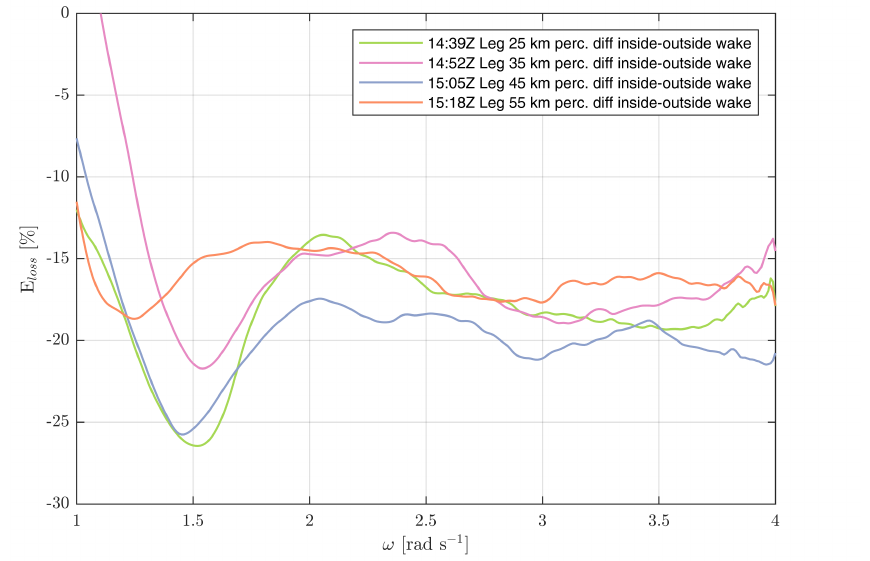
Figure 6. Relative wave energy reduction within the wake compared to the area outside the wake. The reduction is shown as a percent for the legs with a distance of 25, 35, 45, and 55km behind the wind farm. Above 2rads − 1 , the mean relative reduction in the wave energy is around 15–20%, whereas the most significant reduction in energy is visible around the wave